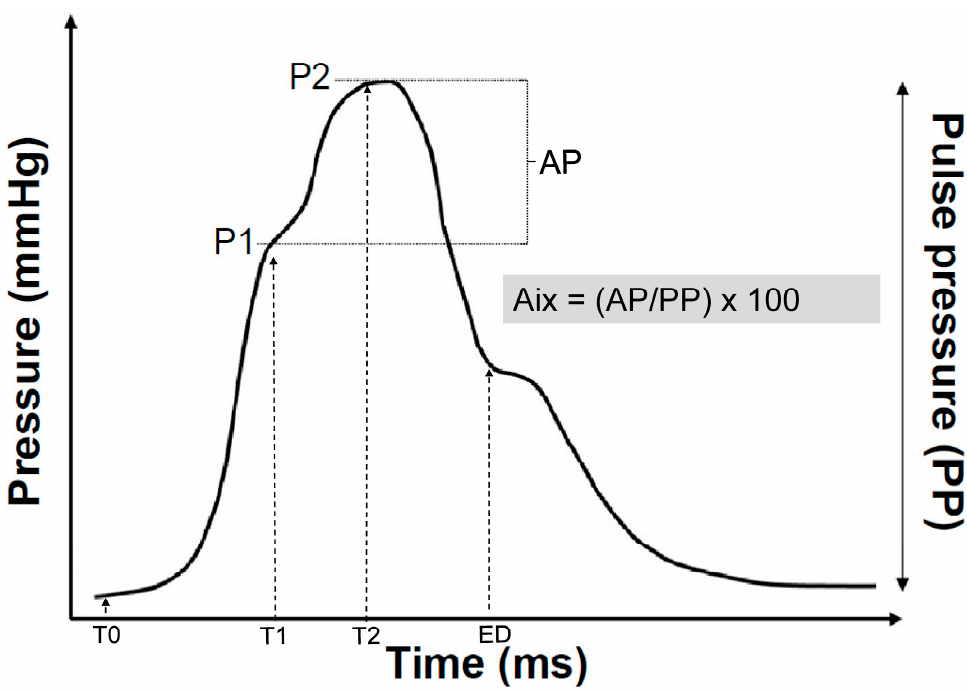
Figure 1. Schematic presentation of the pulse wave curve measured at the A. radialis. After the foot of the pulse (T0), indicating the onset of ejection, the pressure wave rises to an initial peak where it forms a shoulder (P1). This is the peak of the primary left ventricular ejection pressure. The second shoulder (P2) represents the peak of the arterial reflection wave. The difference between P2 and P1 is called augmentation pressure (AP). The end of ejection (ED) is the point of closure of the aortic valve and time of the end of systole. The augmentation index (AIx) is calculated as the difference between the second (P2) and first (P1) systolic peak pressure and is expressed as percentage of the central PP: AIx (%) = [(P2 − P1)/PP] × 100.